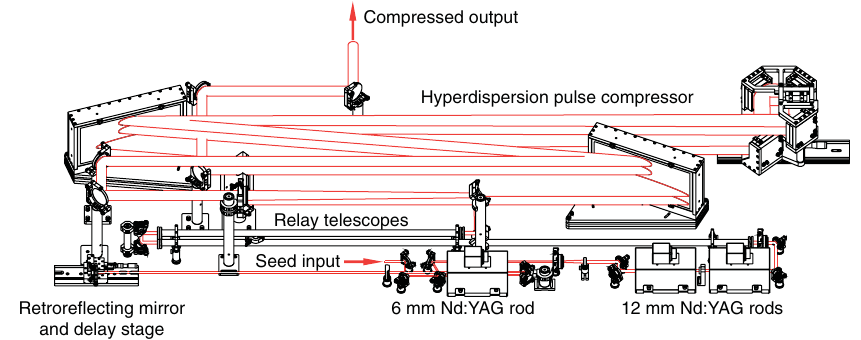
FIG. 5. (Color) Diagram showing the bulk amplifiers and compressor for the interaction laser system. The seed is sent though three Nd:YAG heads then relay imaged and upcollimated for injection into the hyperdispersion pulse